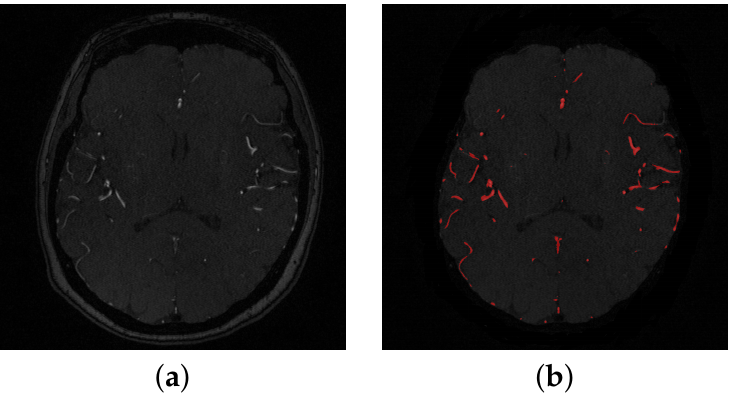
Figure 2. ( a ) A sample of a 2D original slice, ( b ) after bias correction, and ( c ) after skull stripping.